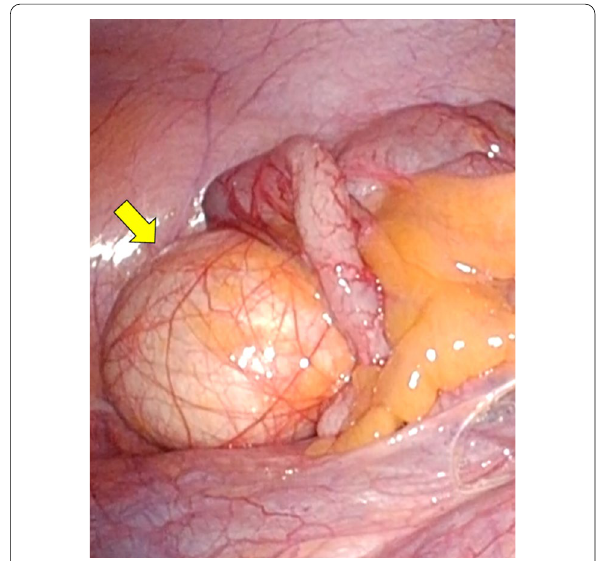
Fig. 3 Intraoperative findings. The tumor is seen as a round, whitish mass arising from the cecum (arrow)